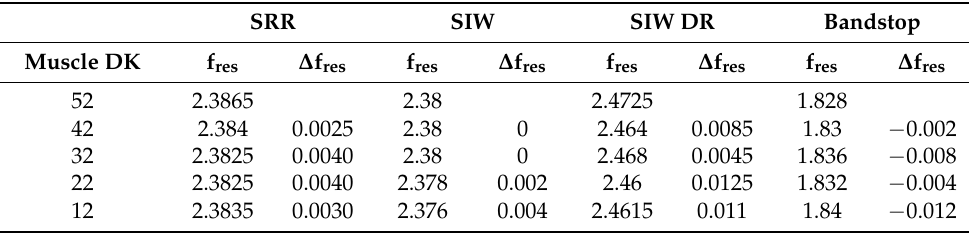
Table 3. Resonance frequency and difference in resonance frequency, compared to normal muscle for the sensors, values in given in GHz.